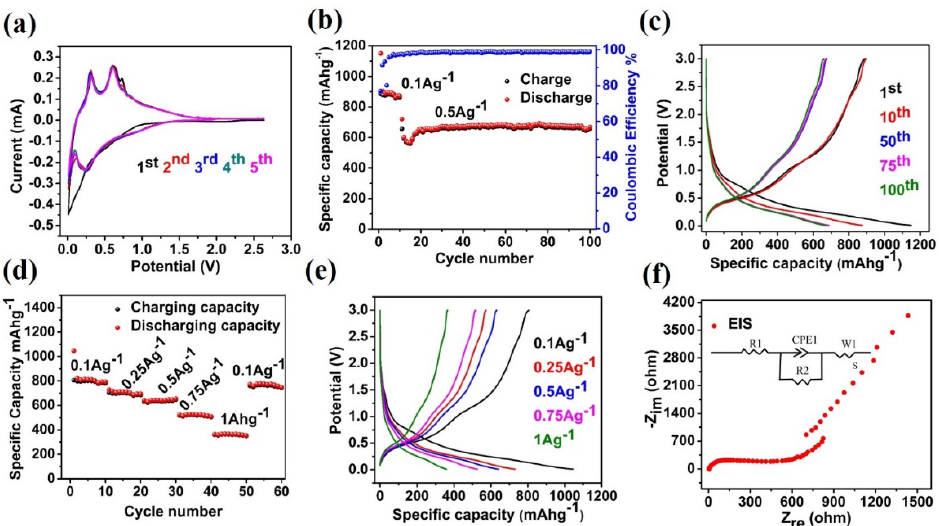
Figure 4. Electrochemical performance of the Sn/C composite electrode in LIBs. ( a ) Initial five CV curves scanned from 0.01 to 2.8 V at a rate of 0.01 mV s −1 . ( b ) Cycle performance of the Sn/C electrode acquired at a current density of 100 mA g −1 . ( c ) The corresponding discharge/charge profiles from selected cycles in ( b ). ( d ) Rate performance of Sn/C at various current densities from 0.1 to 1 A g −1 . ( e ) The typical discharge/charge profiles at various current densities. ( f ) EIS of Sn/C.